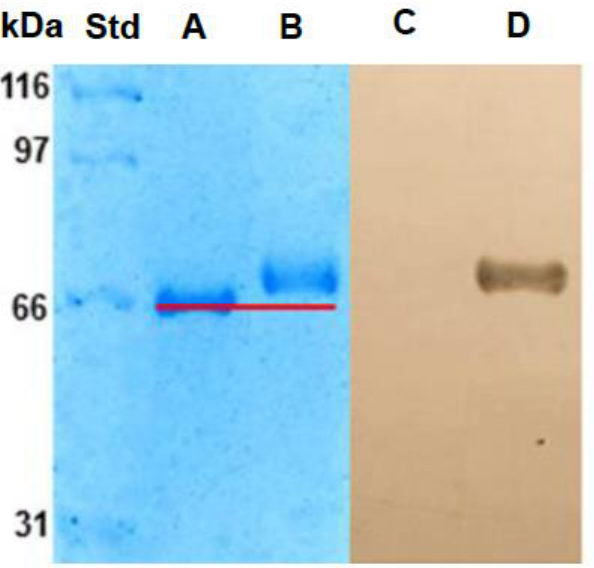
Figure 2. SDS-PAGE profiles and lectin blotting assay of BSA. Lane A, tBSA; Lane B, BSA-Lac; Lane C, tBSA and Lane D, BSA-Lac.